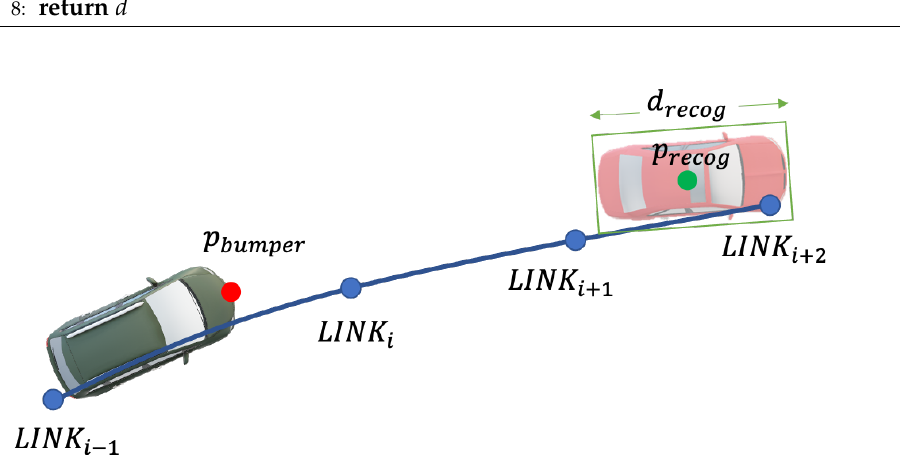
Figure 16. Discrimination-confrontation